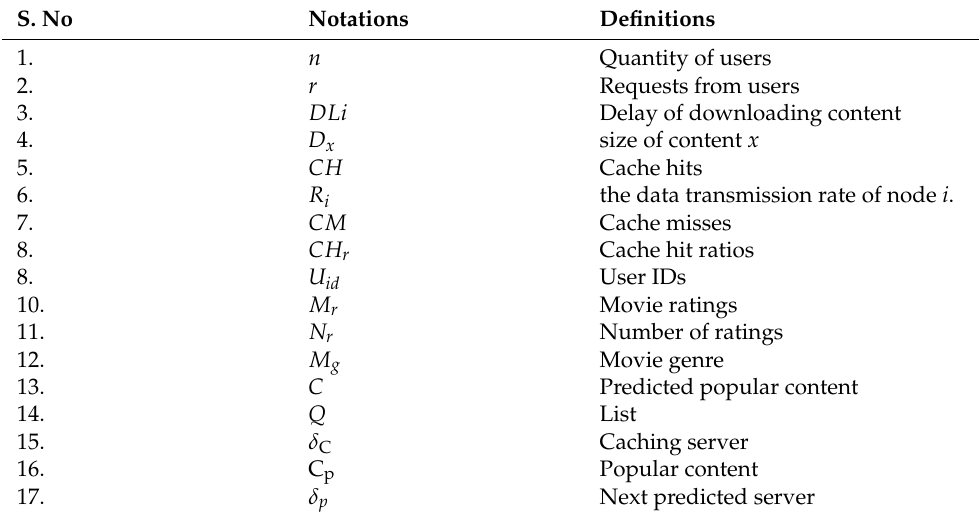
Table 2. Notations and